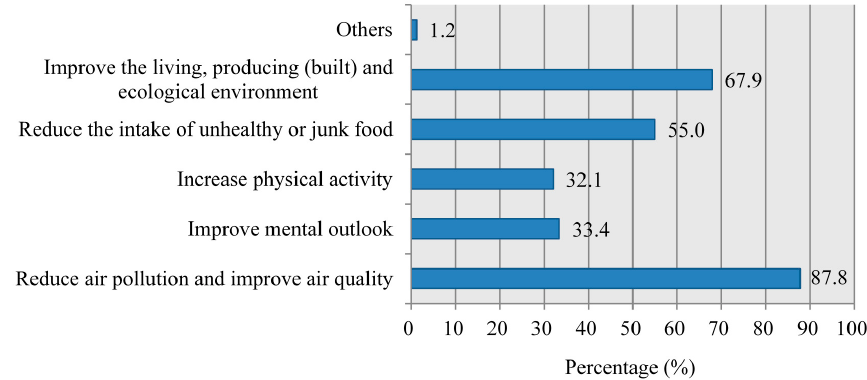
Figure 4. Perceptions of respondents on the pathways of GHG emission reductions to provide ancillary public health benefits.